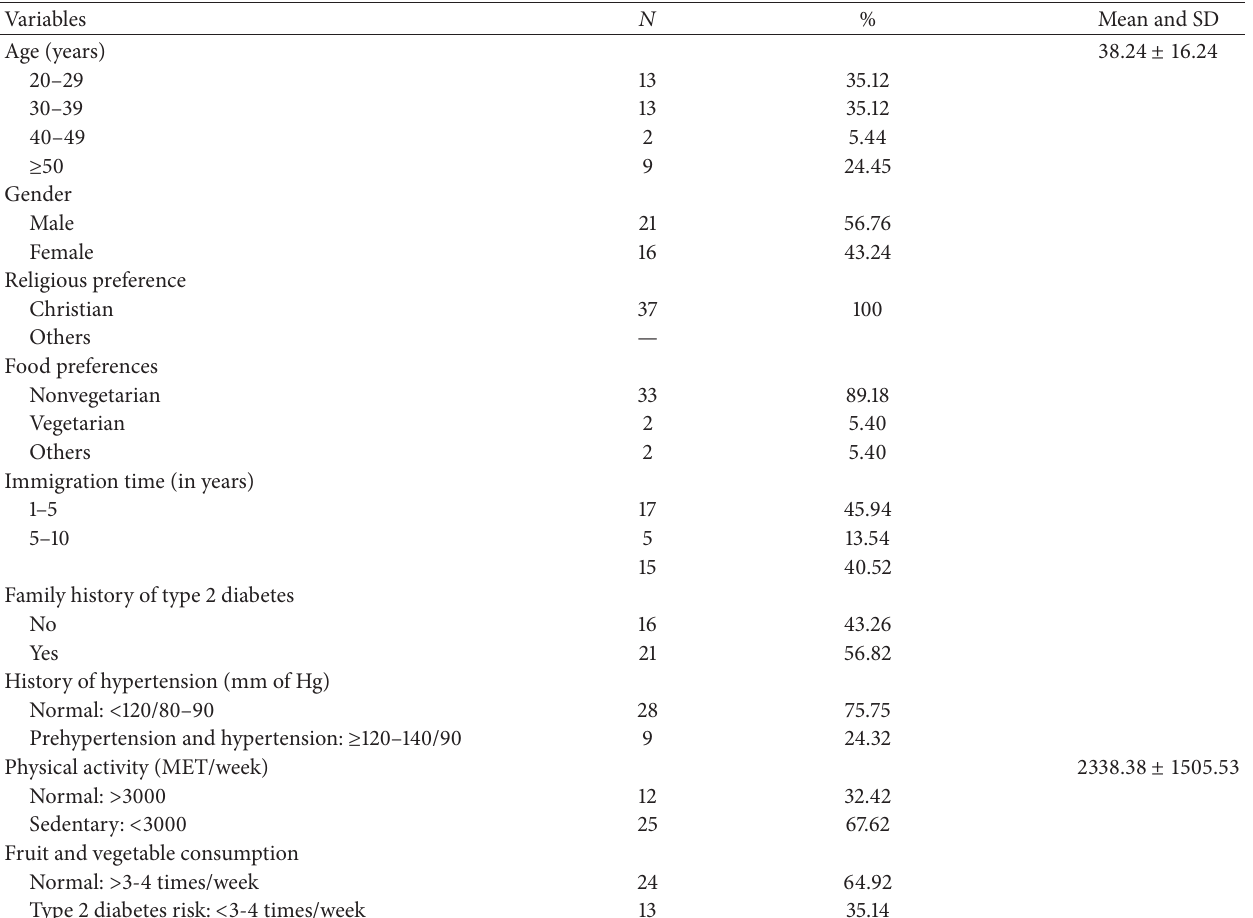
Table 1. The sample consisted of 21 (56.76%) males and